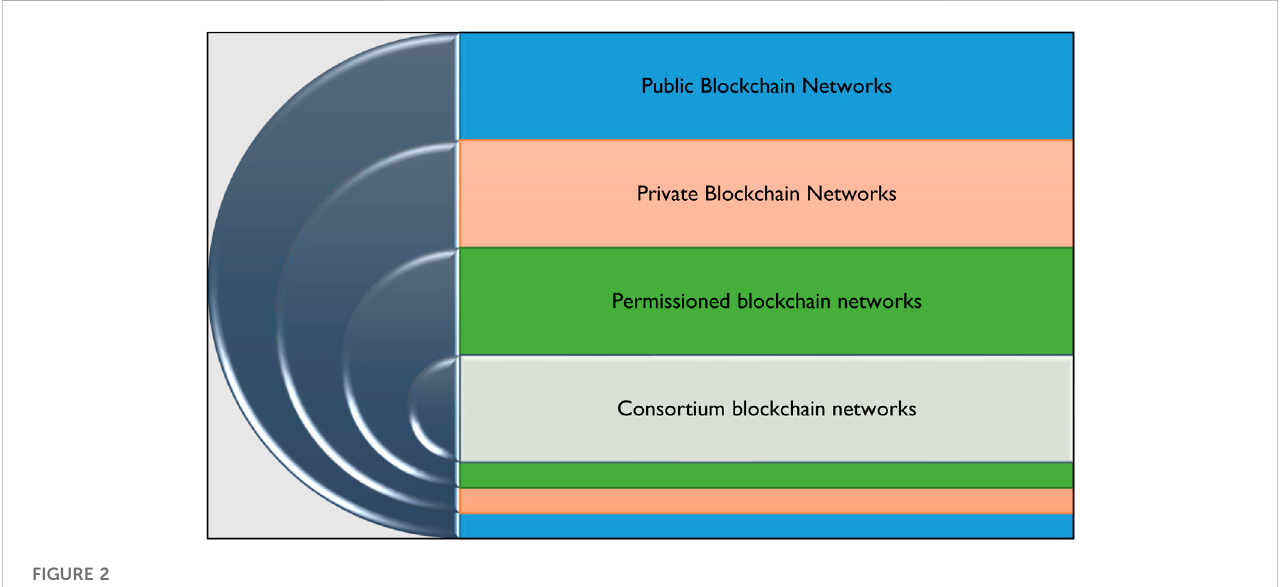
FIGURE 2 Types of blockchain